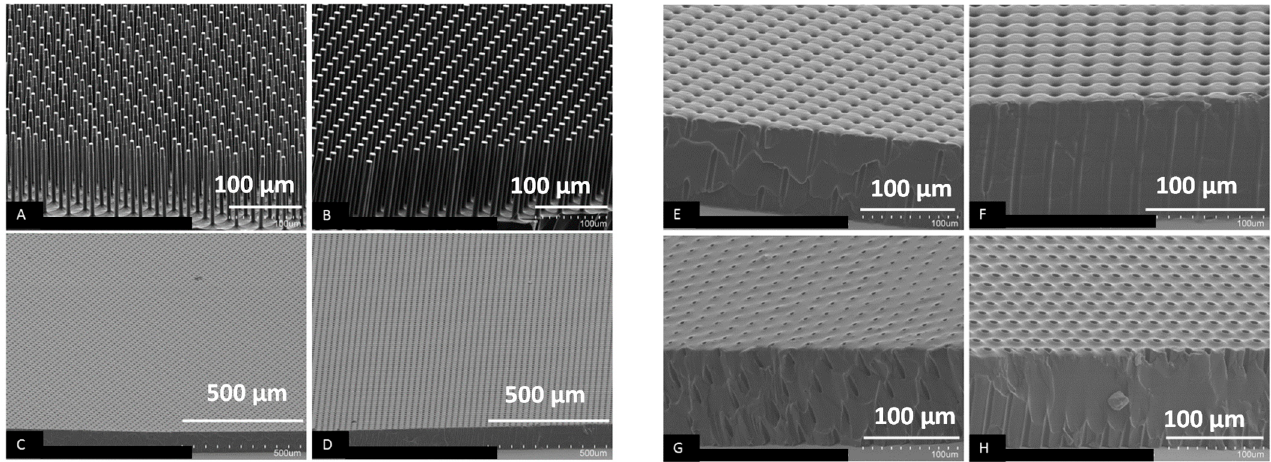
Figure 3. ( A , B ) SEM images of PVA pillars used for fabrication of polymer membranes. The diameter of the tip of a PVA pillar in ( A ) is 5.8 µm at the top and 6.0 µm at the bottom. The diameter of a PVA pillar in ( B ) is 7.7 µm. ( C , E , G ) and ( D , F , H ) are SEM images of the fabricated NOA84 membranes corresponding to the PVA pillars shown in ( A ) and ( B ), respectively. ( C , D , E , F ) are SEM images of the bottom side of these membranes, while ( G , H ) show top side.